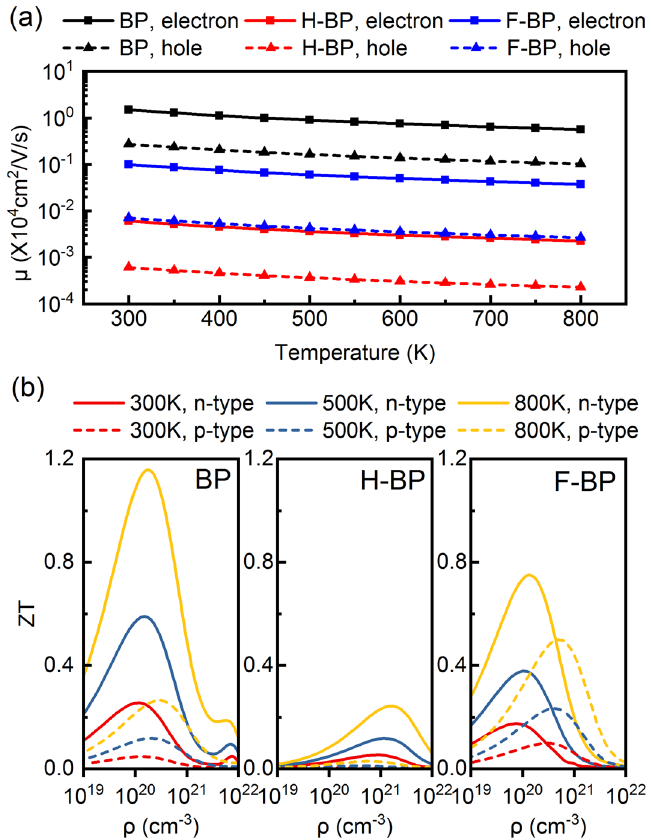
Figure 5. ( a ) The carrier mobility μ and ( b ) the figure of merit ZT with respect to different temperature as a function of carrier concentration ρ for BP, H-BP and F-BP. The solid lines represent n -type doping and the dash lines represent p -type